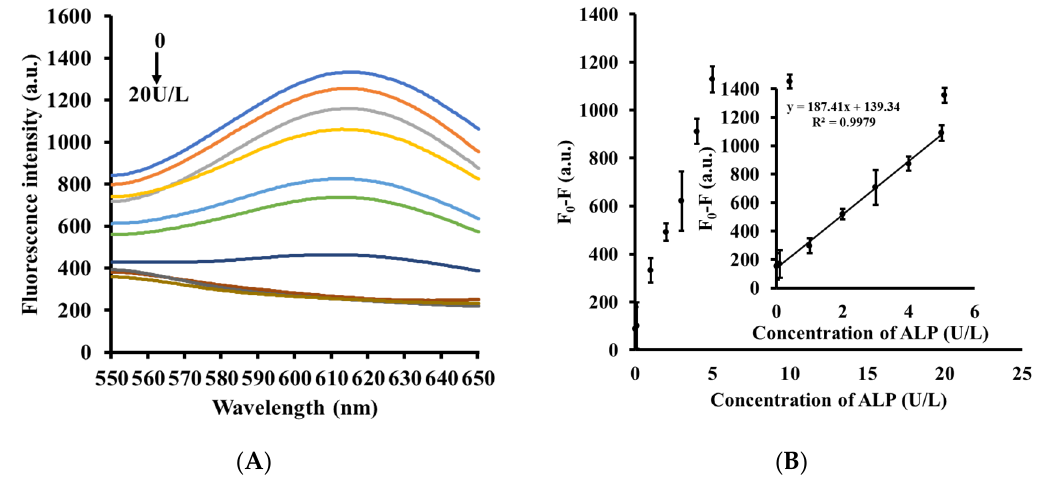
Figure 3. The quantitative measurement of ALP. ( A ) Fluorescence spectra of the assay system response to different activity units of ALP (0, 0.01, 0.1, 1, 2, 3, 4, 5, 10, and 20 U/L); ( B ) the plot between F 0 -F and the concentration of ALP. Inset: calibration linear curve for ALP detection. Table 1. Comparison of different methods for the detection of ALP.